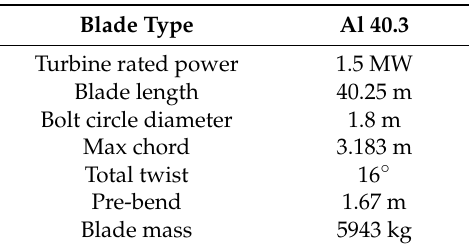
Table 1. Al 40.3 m blade data.